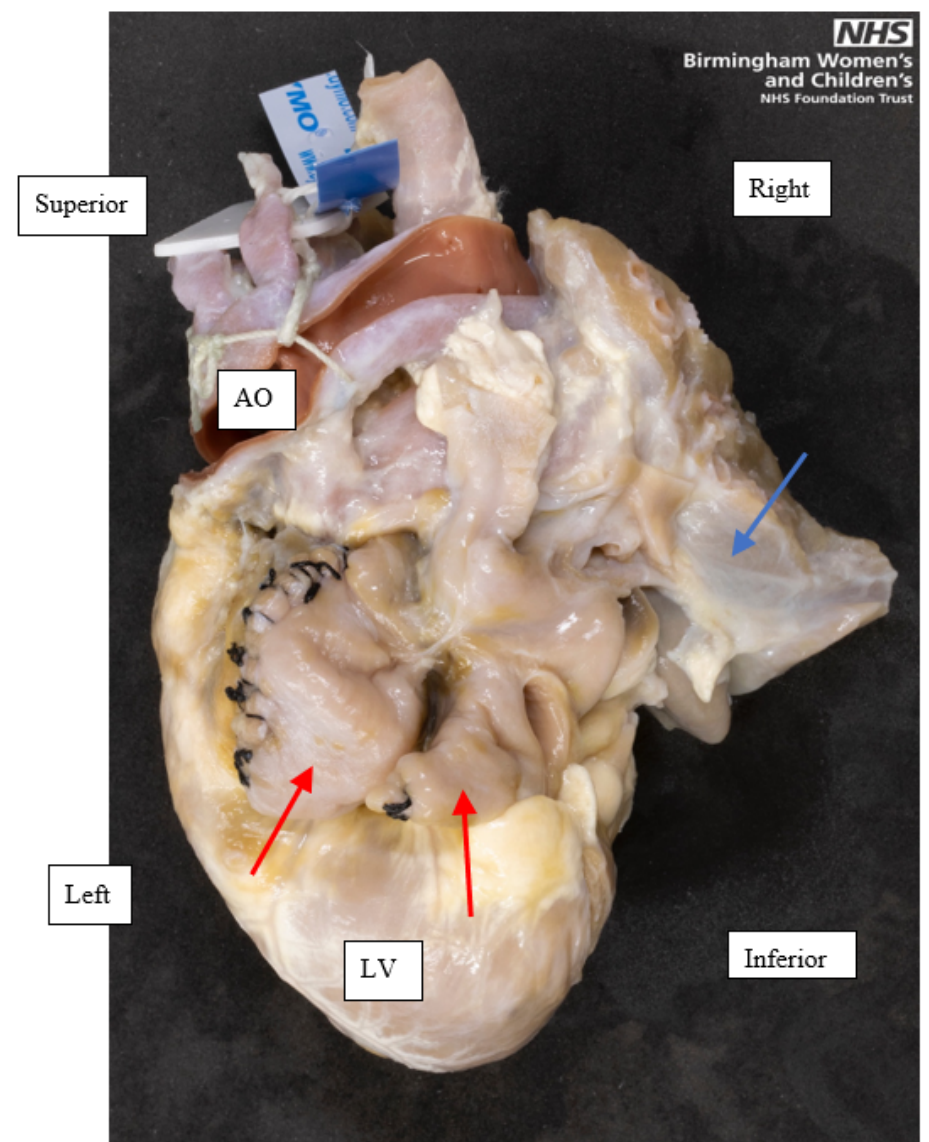
Figure 2. A left posterior view of a heart with left atrial isomerism, showing the juxtaposed morphologic left atrial ap- pendages, indicated by the red single-headed arrows. Both appendages are tubular and had a narrow base to the atrium. Parts of the lungs, indicated by the blue single-headed arrow, have been moved to the right and superiorly to expose the appendages. This heart had been operated on in life, indicated by the black stitches in both appendages. Orientation points displayed in an attitudinally correct fashion. AO, Aorta; LV, Left ventricle. We found atrial septum anomalies (Figure 3) in all seven hearts, consistent with the landmark study by Professor Anderson and colleagues in which they found the atrial sep- tum was rarely properly formed in left atrial appendage isomerism [1]. We also found incidences of common atrioventricular (AV) valve (5/7, 71%) and common AV junction (6/7, 86%) similar to those found by Anderson [1], indicating the importance of using con- sistent diagnostic criteria so studies are able to be accurately compared.